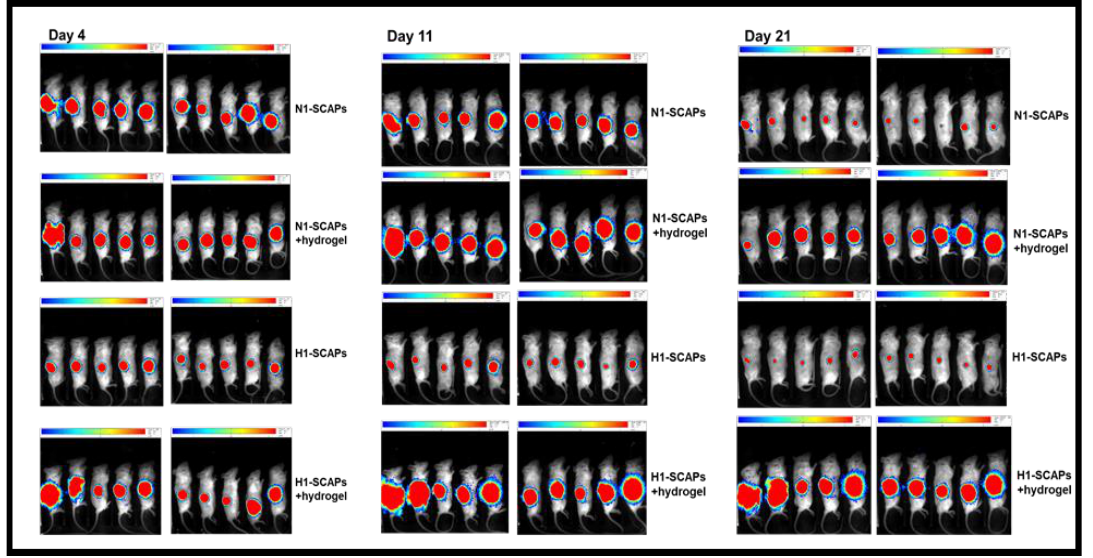
Figure 5. Bioluminescence imaging of mice analyzed 4, 11 or 21 days after sub-cutaneous injection of SCAPs. The quantity of surviving SCAPs-Luc + from donor 1 grown at 21% (N1-SCAPs) or 3% O 2 (H1-SCAPs), and injected alone or included in the hydrogel was measured by luminescence. It was measured for 3 min at the same gain for all mice (n = 10/condition). The Luc measurements were used to draw graphs shown in Figure 6.